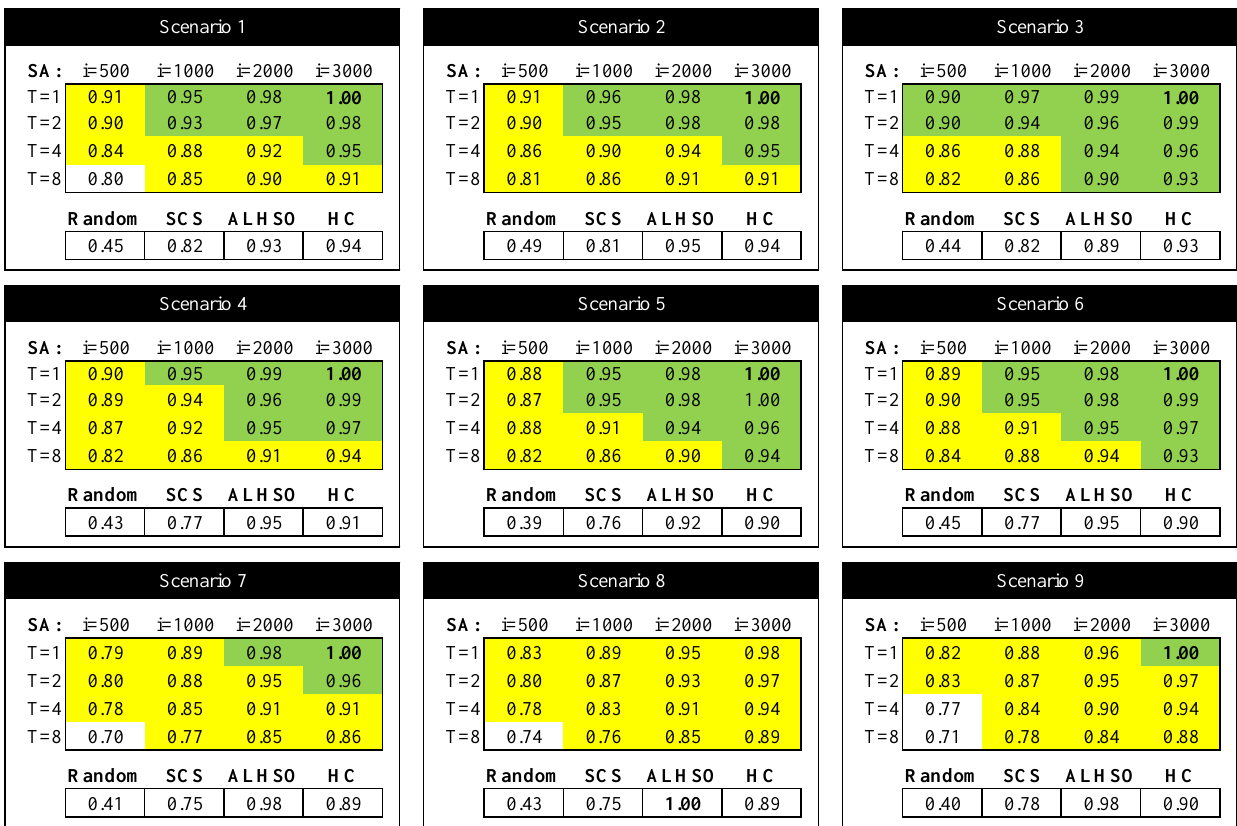
Figure 8. Results relatives to the